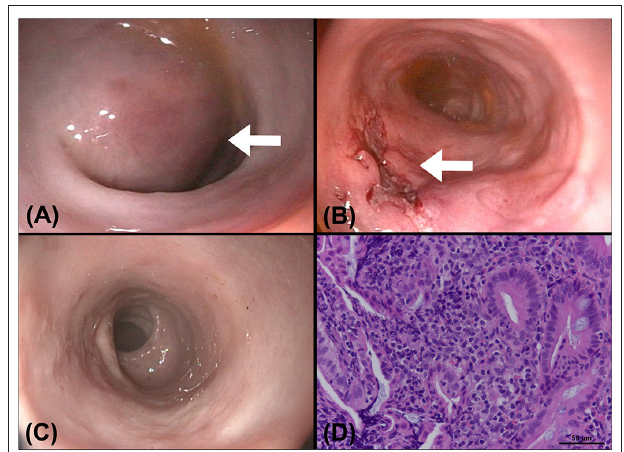
FIGURE 4 | A colonoscopy was performed after a CT examination. (A) A round submucosal mass (arrow) with an intact mucosa was noticed at the descending colon, causing narrowing of the colonic lumen. (B) The colonoscopic image obtained after surgical evacuation of the contents in the mass: the incision wound (arrow) was kept open for drainage of the remaining blood clots. (C) Image of a follow-up colonoscopy 1 month after evacuation: the incision wound was well-healed, and no recurrence was seen. (D) Pathology of the colonic specimen showed chronic proctitis and lymphoid hyperplasia of the colon. A small number of lymphocytes and plasma cells with fewer neutrophils are noted multifocally in the lamina propria of colon (H&E stain, bar = 50 µ m, 400 ×